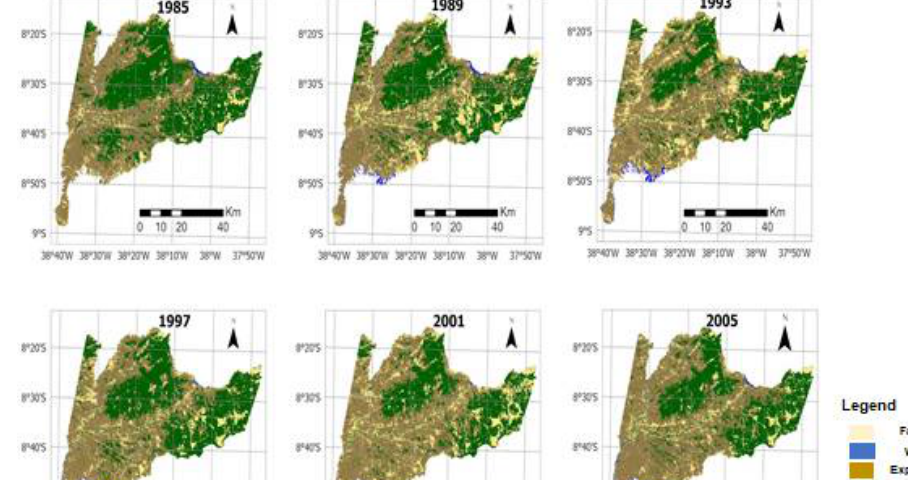
Figure 3. Dynamics and quantification of thematic classes through digital classification in the municipality of Floresta-PE.